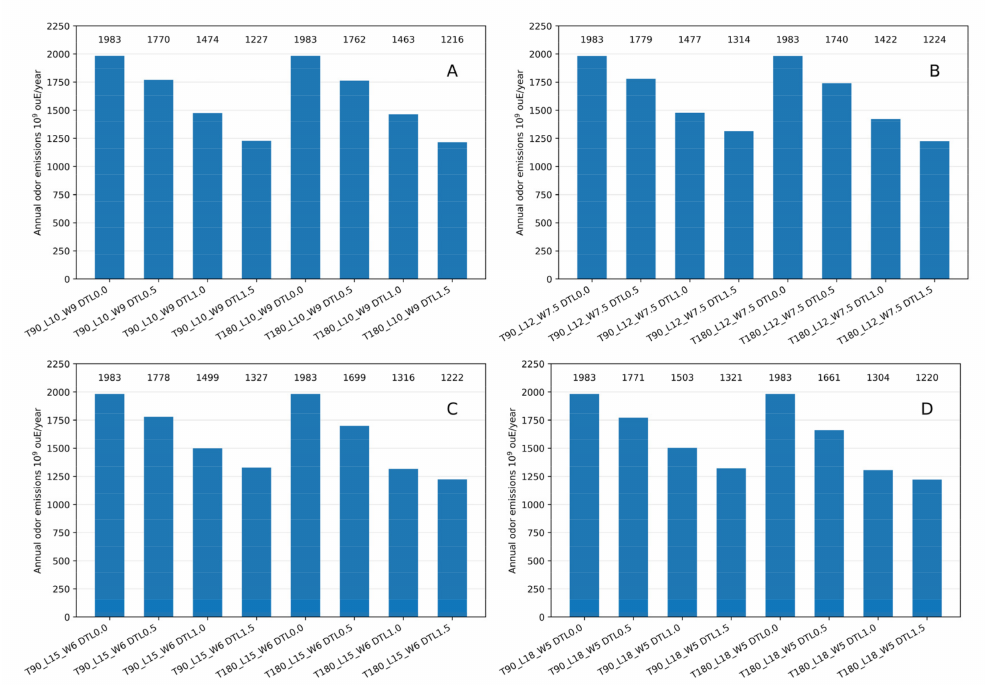
Figure 8. Annual emissions of odor (10 9 ouE/year) for the different tanks and scenarios. ( A ): tank L10_W9, shape factor 1.11. ( B ): tank L12_W7.5, shape factor 1.60. ( C ): tank L15_W6, shape factor 2.50. ( D ): tank L18_W5, shape factor 3.60.